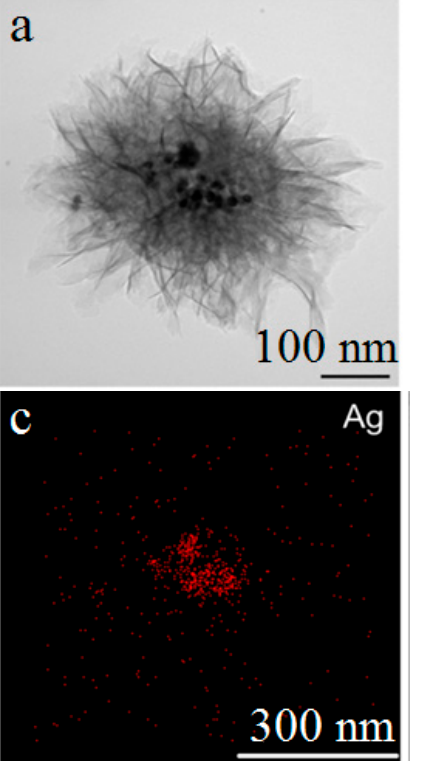
( b ) Figure 2. XRD pattern ( а ) and particle size distribution ( b ) of Al/Ag nanoparticles. The water oxidation of the Al/Ag nanoparticles at 60 °C (sample one) led to the formation of nanosheet agglomerates with sizes up to 1 μ m, at the center of which they were enriched with silver nanoparticles with average sizes of approximately 17 nm (Figure 3). Previously, the water oxidation of the EEW aluminum nanoparticles was